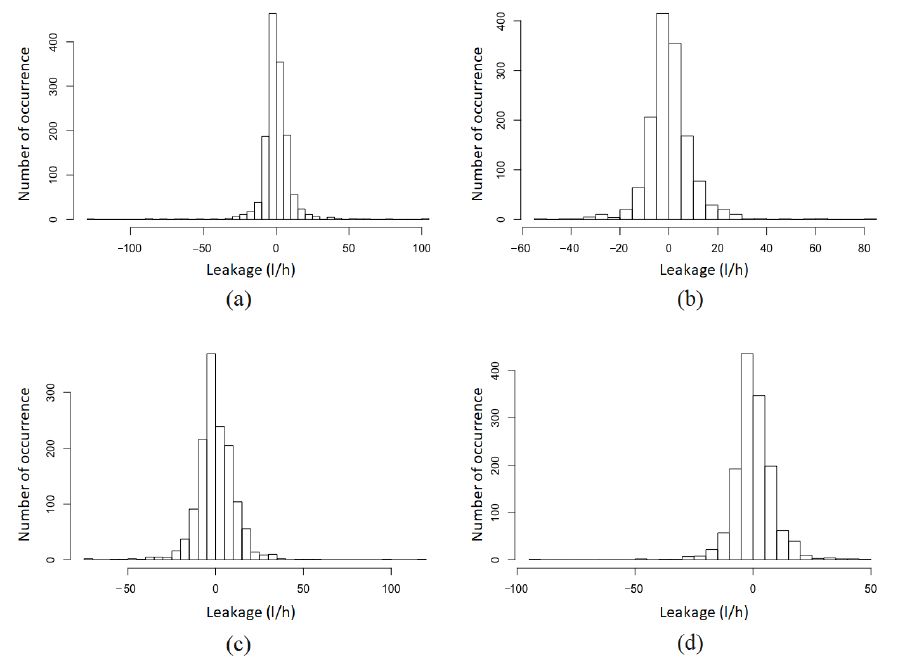
Figure 3. Histogram of the four systems degradation data ( a ) System 1, ( b ) System 2, ( c ) System 3, ( d ) System